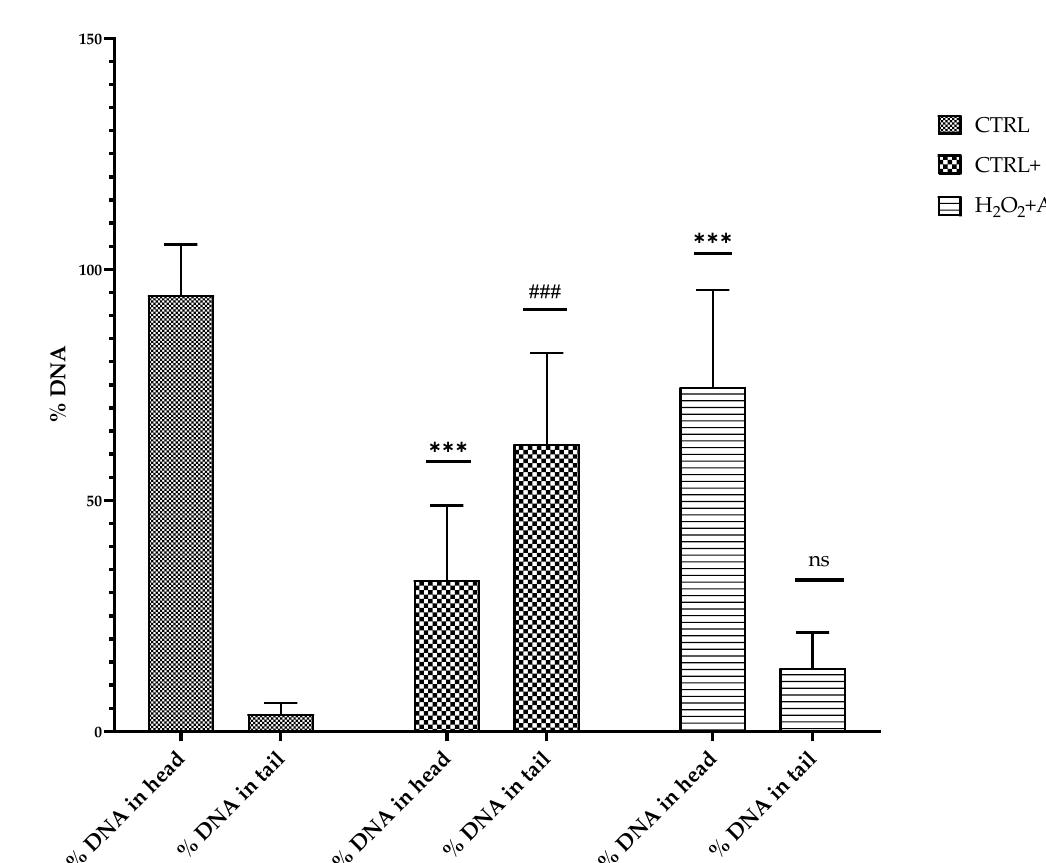
Figure 9. The percentage of DNA in head and tail in control sample (CTRL, cells without treatment), in CTRL + (cells treated with 75 µM H 2 O 2 ), and H 2 O 2 + AALipo20%. Results are expressed as mean ± SD and significant differences shown when compared with % DNA in the head (*** p < 0.0001) and tail (### p < 0.0001) of the control, CTRL.